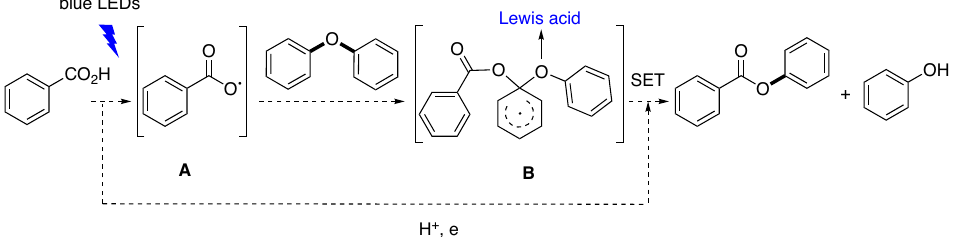
Fig. 2 Designed pathway of visible-light photoredox-catalyzed acidolysis of diaryl ethers with an aryl carboxylic acid. Photoredox catalysis affords an aryl carboxylic radical ( A ), then followed by its electrophilic attack on the diphenyl ether to afford B , and a single electron transfer (SET) with a proton